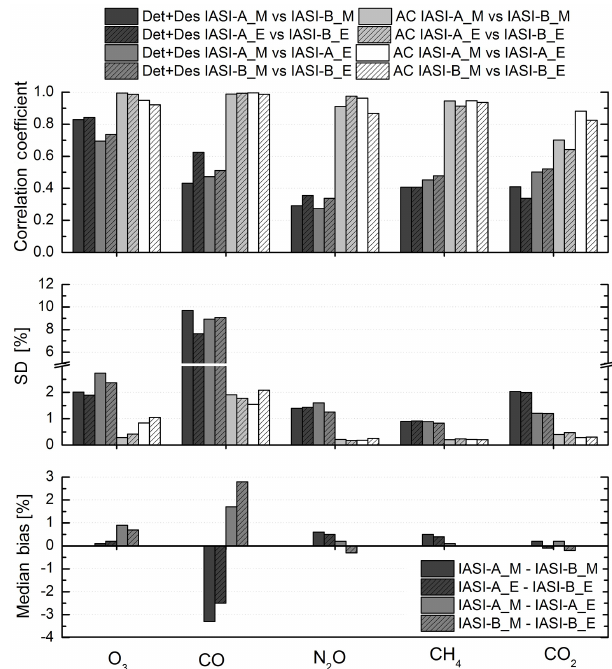
Figure 5. Pearson correlation coefficient (upper panel) between the observations from IASI-A and IASI-B overpasses (morning, M, and evening, E) for all the trace gases considered at different timescales: single measurements (de-trended and de-seasonalised variability, Det + Des) and annual cycle (AC). Middle panel shows the same, but for the standard deviation (in %) of the corresponding differ- ences, while the bottom panel displays the median bias (in %). The number of coincident observations is